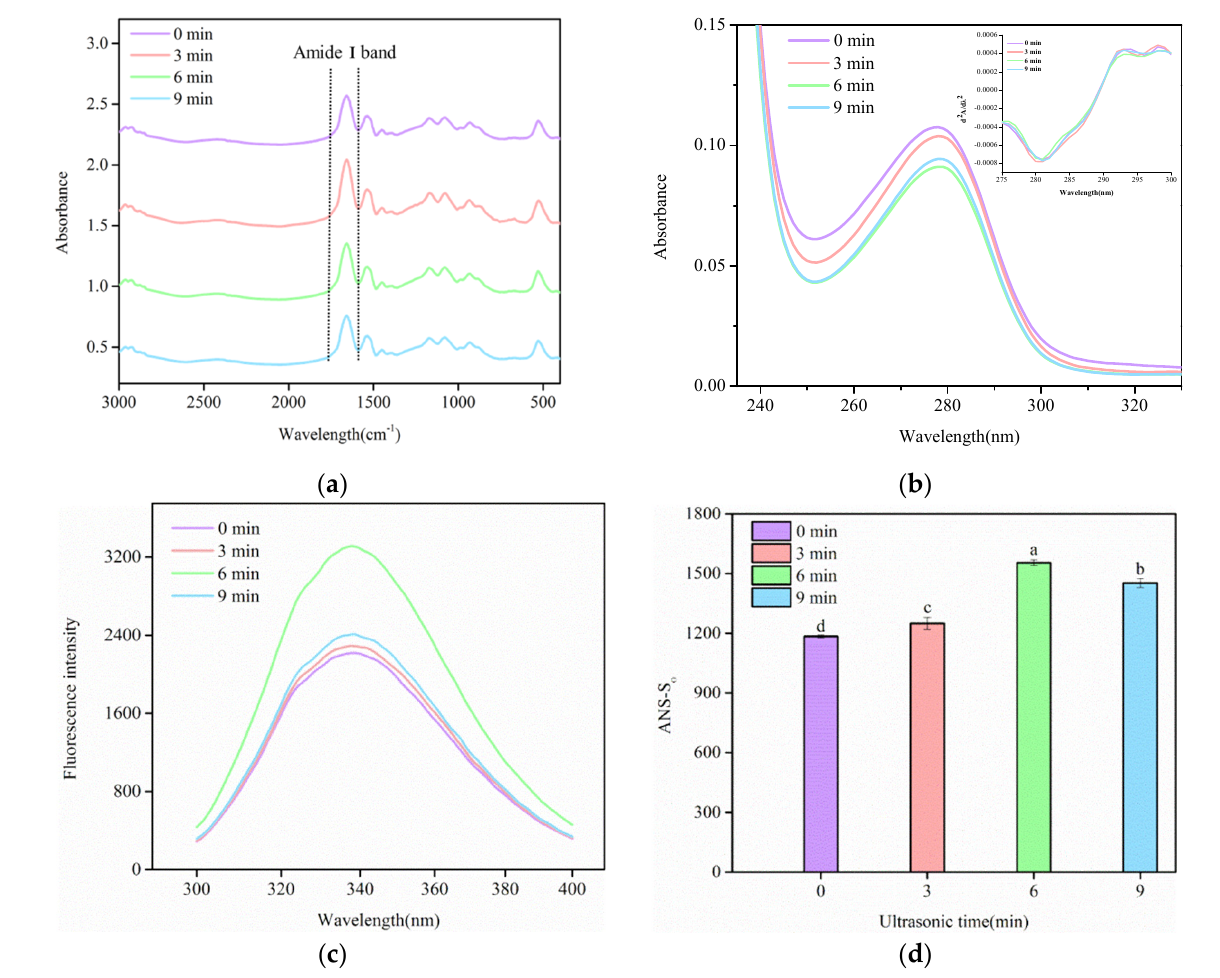
Figure 2. Changes in the structure of SC as a result of high-intensity ultrasound treatment. ( a ) FTIR spectrum; ( b ) UV–Vis spectroscopy; ( c ) intrinsic fluorescence spectroscopy; ( d ) surface hydrophobicity. Different letters above standard deviation bars are significantly different ( p < 0.05). Table 2. Effect of high-intensity ultrasound treatment on the secondary structure of SC.